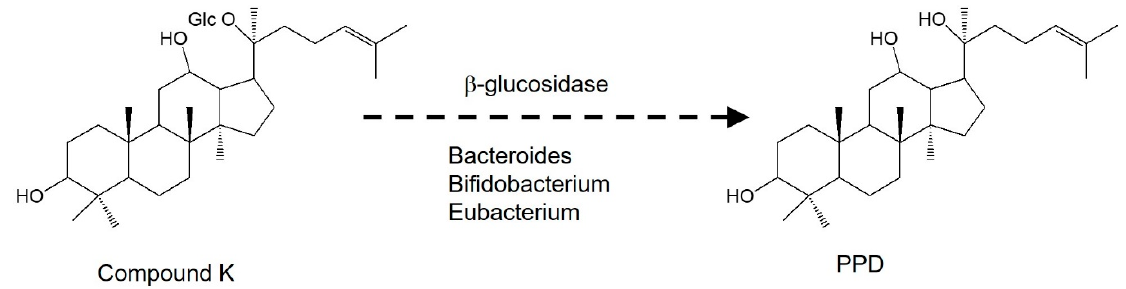
Figure 5. Structure and reported metabolic pathway of compound K to PPD. Glc: glucose; PPD: 20(S)- protopanaxadiol.